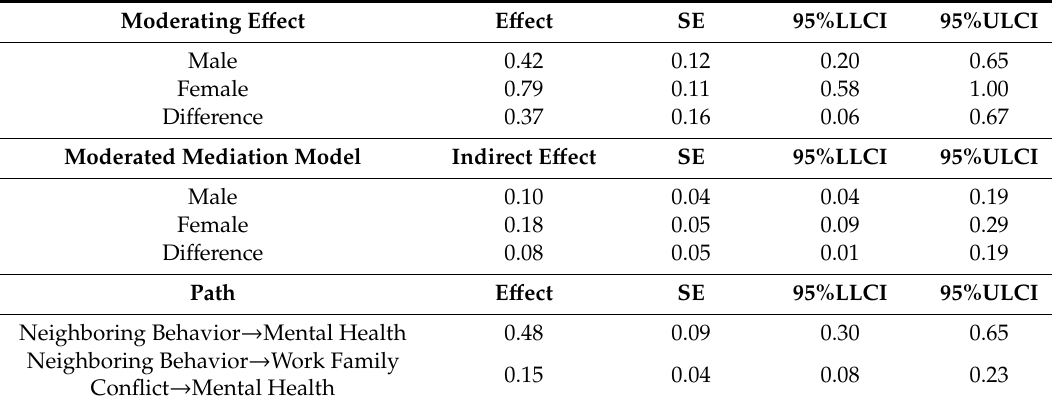
Table 5. Results of Bootstrapping Test.